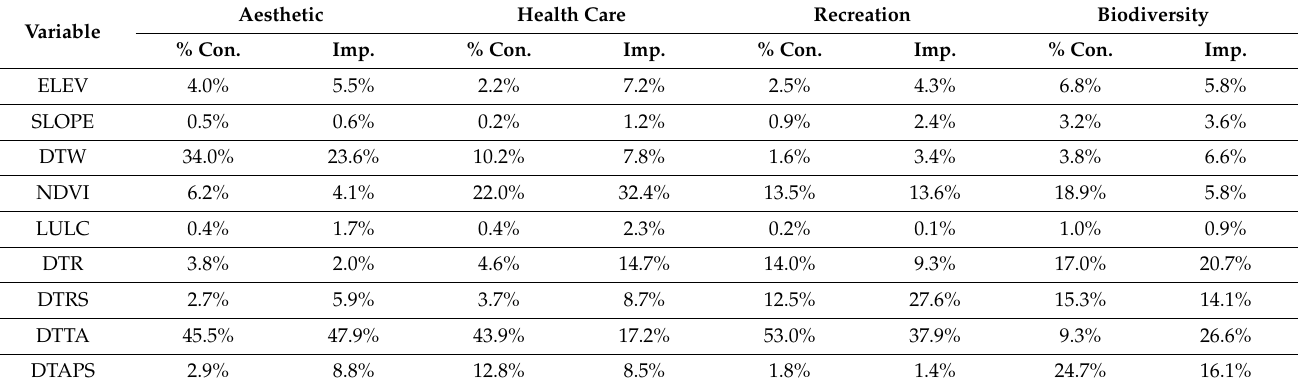
Table 7. Percent contribution (% Con.) and permutation importance (Imp.) of variables.